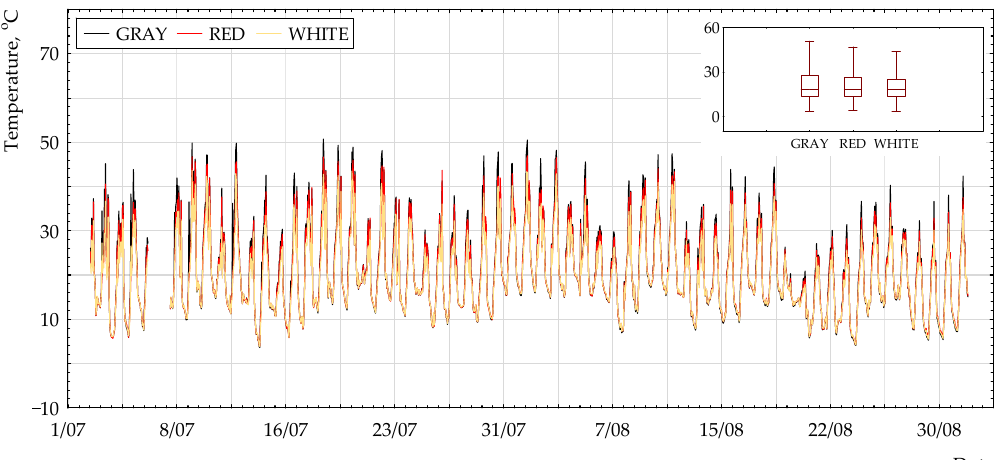
Figure 2. Surface temperature (N_45 ◦ ) for the period of 1 July to 31 August